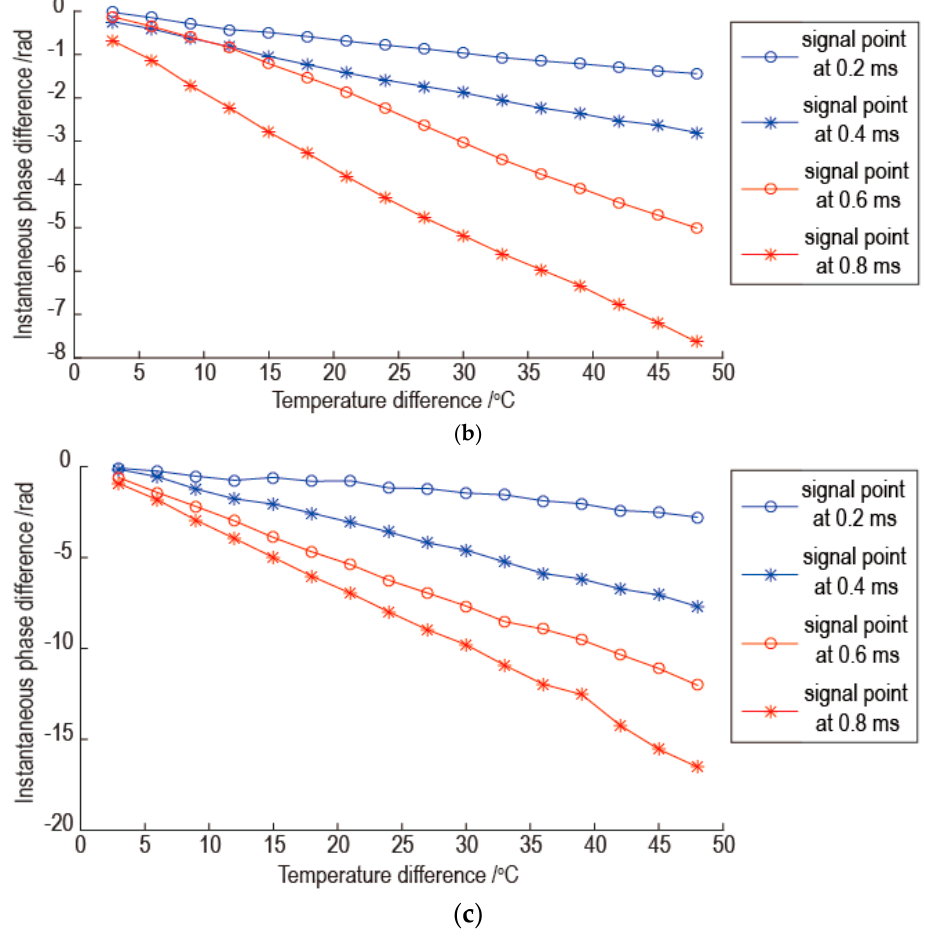
Figure 5. The relationships between the instantaneous phase difference and the temperature difference: ( a ) Signal with frequency 50 kHz; ( b ) Signal with frequency 130 kHz; ( c ) Signal with frequency 210 kHz. Before the temperature compensation, the experimental signals are processed by band pass filter, and the electronic crosstalk is removed. Then the experimental signals are processed by the proposed temperature compensation method using different baseline signals and reference